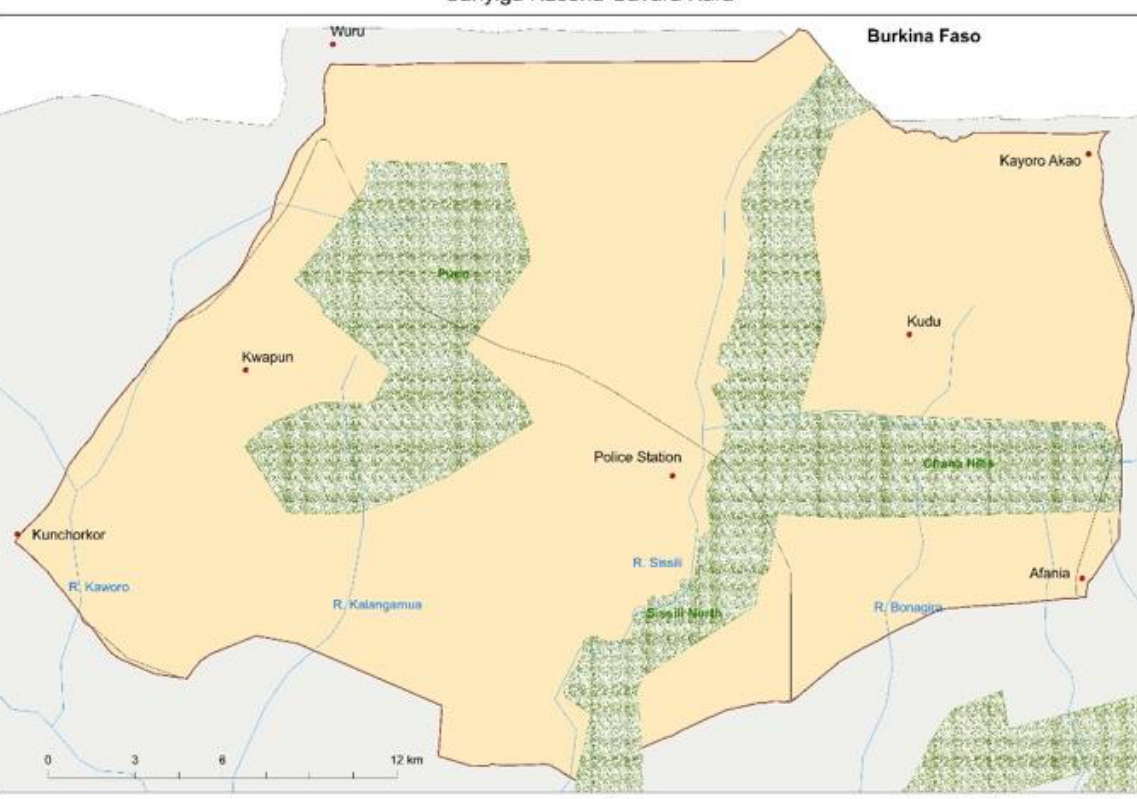
Figure A1. Map A: Sanyiga Kasena Gavara Kara (SKGK) CREMA.